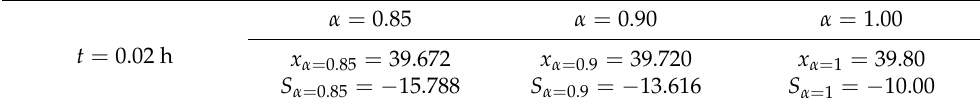
Table 2. Locations (km) and moving jam speeds (km/h) correspond to various values of the α order. t = 0.02